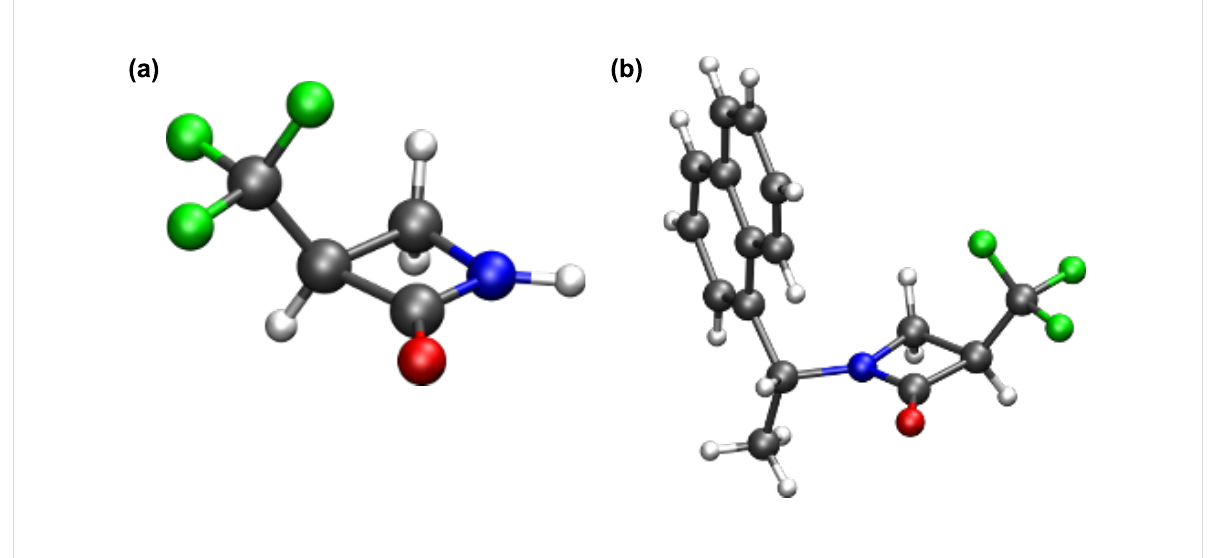
Figure 2: X-ray structures of (a) β -lactam ( S )- 1 and (b) ( α R ,3 R )- 5c . (a) Determination of the absolute stereochemistry of ( α R ,3 R )- 5c by X-ray crystal- lography allowed an absolute assignment of β -lactam 1 .